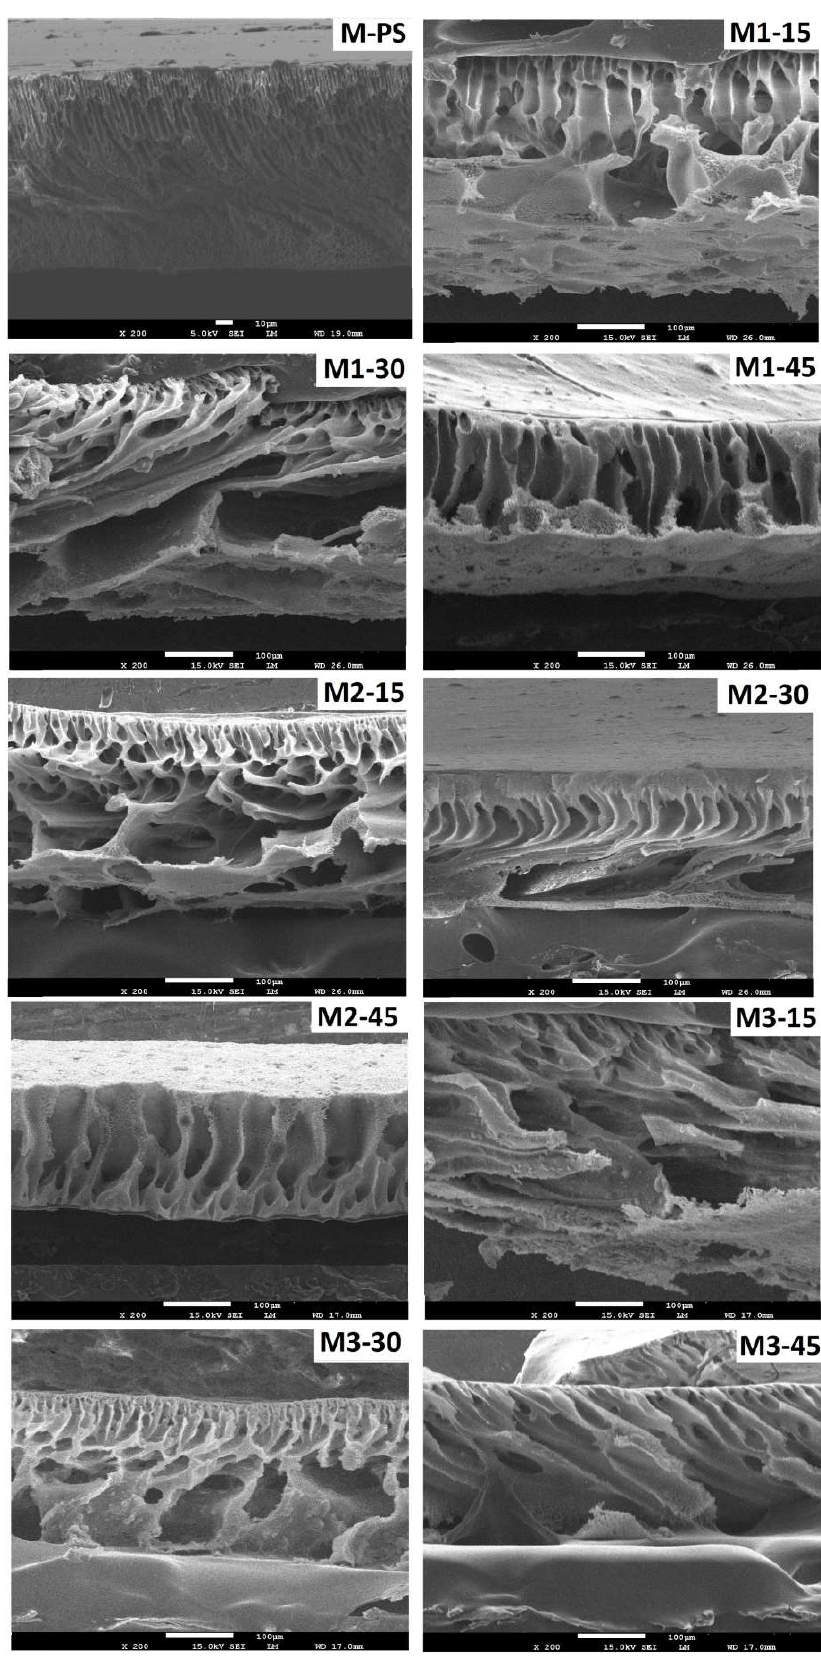
Figure 5. FESEM cross sectional images of PES membrane with and without the incorporation of NCs and S-PES.